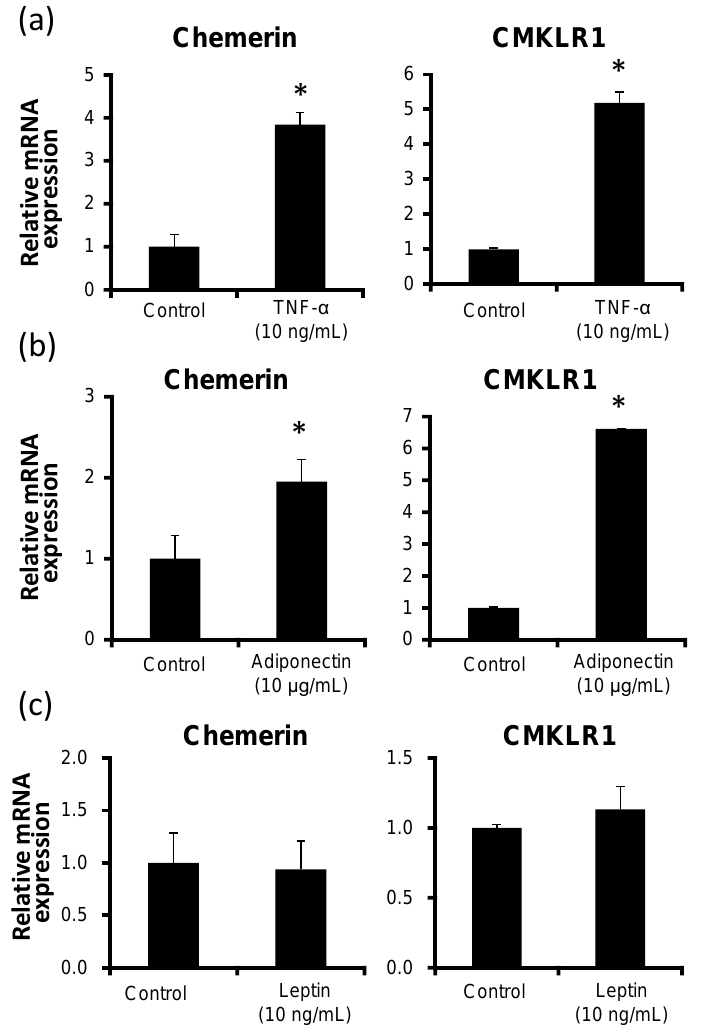
Figure 2. Gene expression levels of chemerin and CMKLR1 mRNA in bovine differentiated adipocytes treated with TNF-  (a), adiponectin (b) and leptin (c). The data are shown as means  SEM and represent data collected from at least three experiments. The data were normalized with 18s rRNA and shown as means  SEM in relative to the levels of control cells (* p<0.05 vs